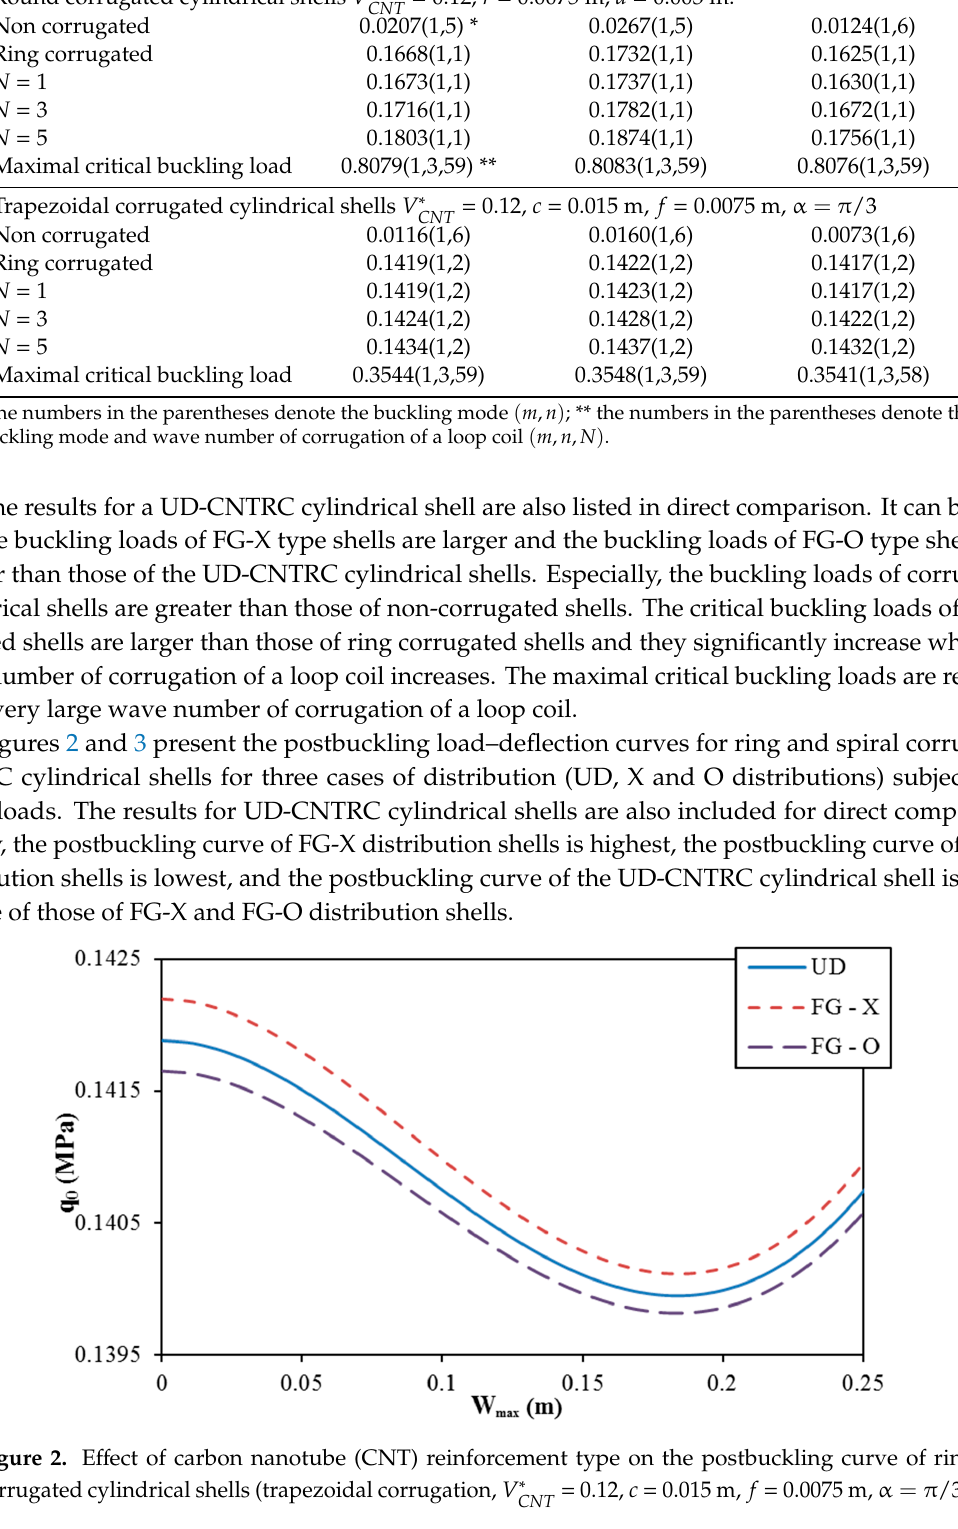
= 0.12, c = 0.015 m, f = 0.0075 m, α = π CNT